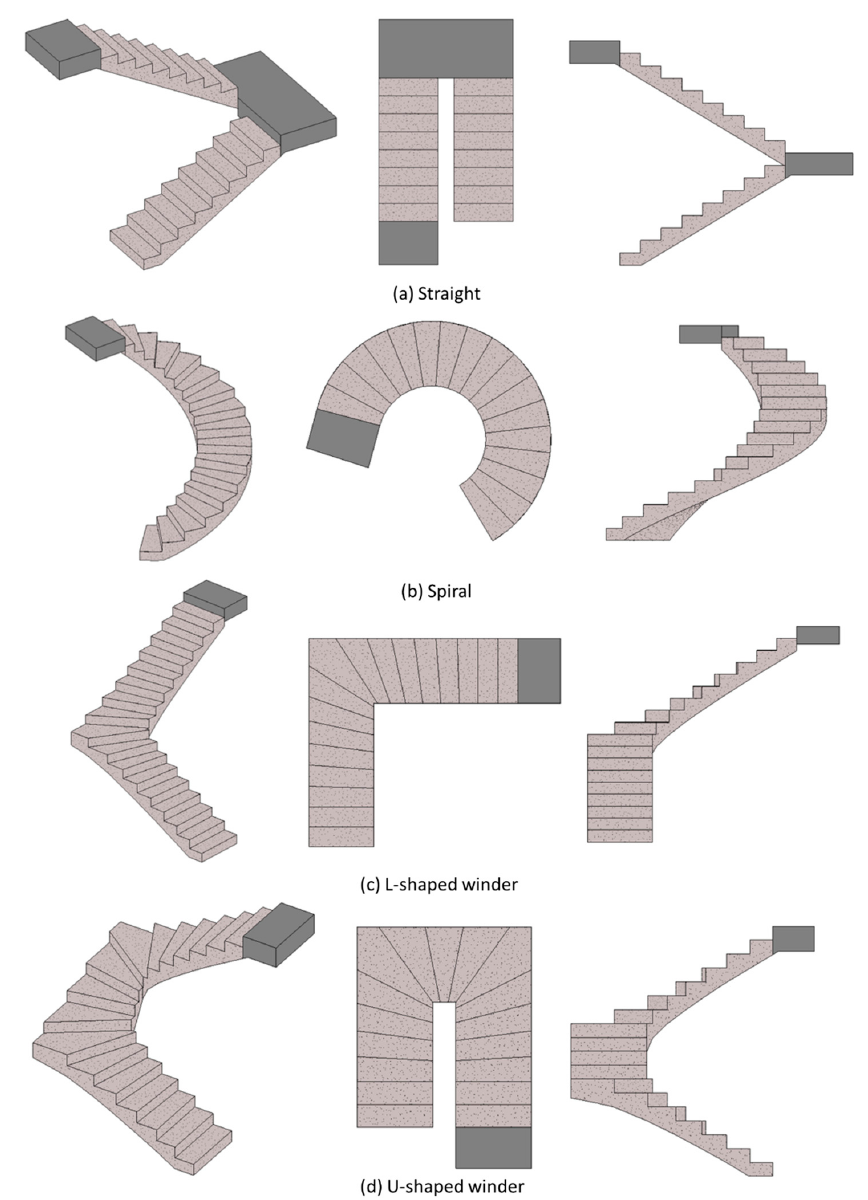
Figure 4. Categories of stair run orientations.